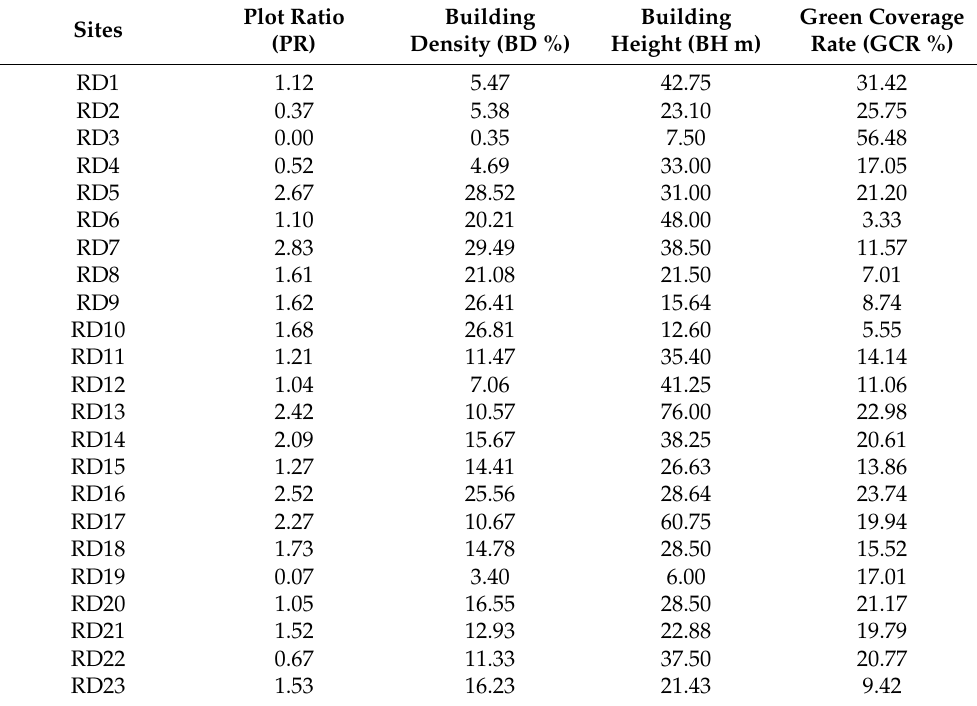
Table 2. Urban morphology index of each site of the residential district.